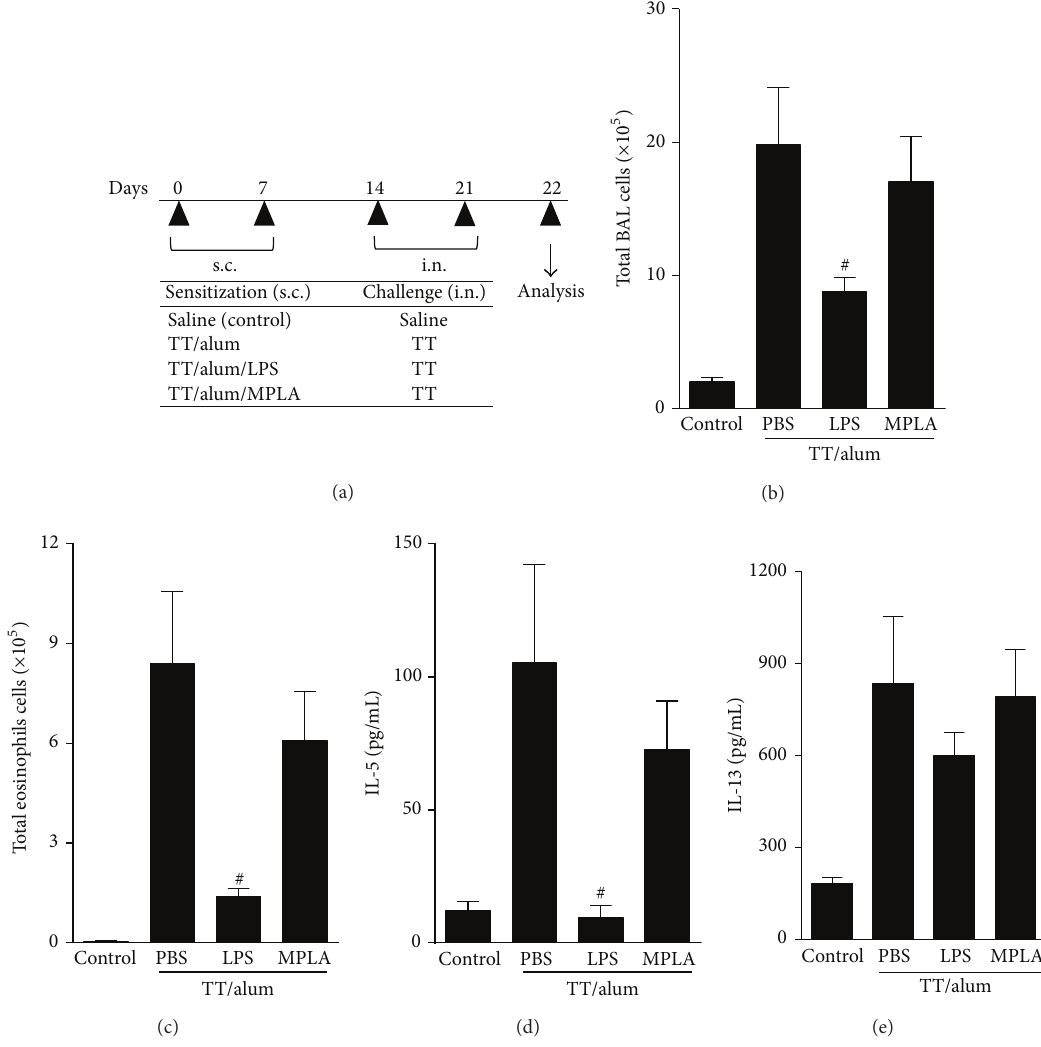
Figure 2: Effects of adsorption of LPS or MPLA onto TT/alum sensitization on TT-mediated airway allergic responses. (a) Protocol: BALB/c mice sensitized with s.c. TT/alum in the presence or not of LPS (10 𝜇 g) or MPLA (10 𝜇 g) on days 0 and 7, and challenged with TT i.n. on days 14 and 21. Samples obtained on day 22: (b) total number of cells and (c) eosinophils in BAL; ((d) and (e)) levels of IL-5 and IL-13 in BAL. Data shown as mean ± SE, one-way ANOVA: # 𝑃 < 0.05 ; different from TT/alum/PBS group ( 𝑛 = 5 ), and experiment was repeated